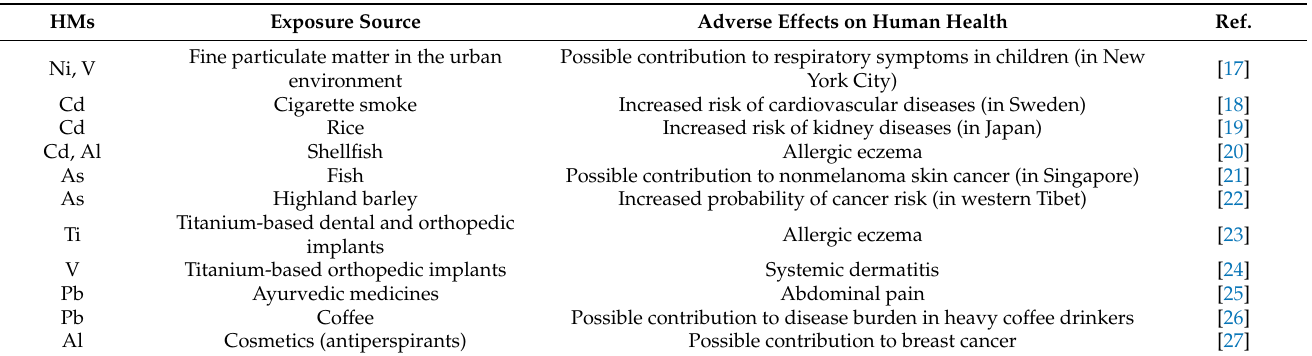
Table 1. Potential non-occupational exposures to heavy metals